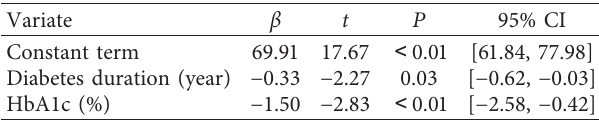
Figure 4: Scatter plots of peripapillary density and influencing factors. Table 5: Multiple regression analysis of peripheral blood flow density factors and systemic factors.